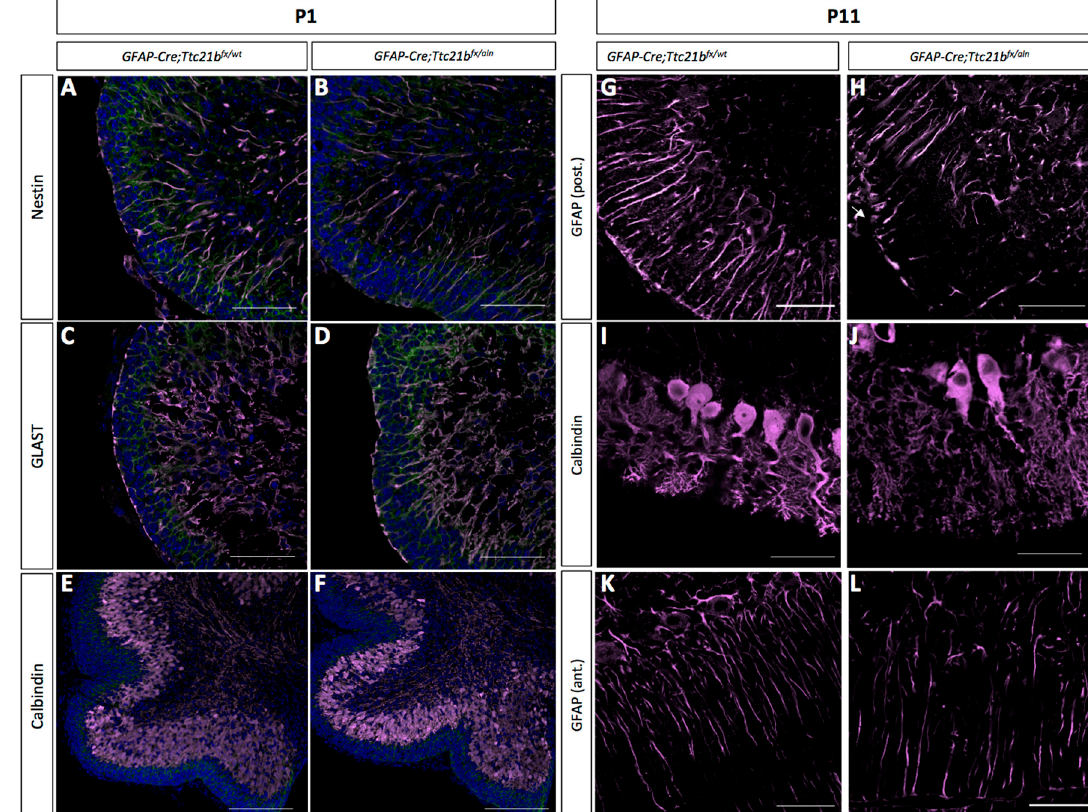
Figure 3. Purkinje cells and Bergmann glia development is disrupted in the GFAP-Cre;Ttc21b fx / aln cerebella. ( A – D ) Immunostaining for immature astrocytes at P1 with Nestin ( A , B ) and GLAST ( C , D ) appears similar between control and GFAP-Cre;Ttc21b fx / aln animals. ( E , F ) Calbindin immunostaining highlights the presence of Purkinje cells at P1 in both control and GFAP-Cre;Ttc21b fx / aln animals. ( G – J ) P11 GFAP-positive mature astrocytes ( G , H ) and Calbindin-positive Purkinje cells ( I – L ) appear abnormal in the lower lobes of the GFAP-Cre;Ttc21b fx / aln cerebella. ( K , L ) Anterior lobes still show normal Bergmann glia morphology in all animals. n = 3 for each genotype. Scale bars 50 μ m.